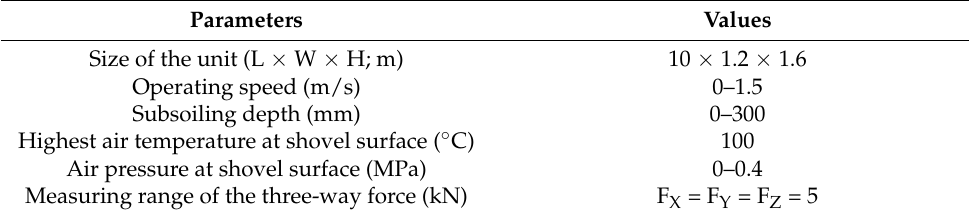
Figure 5. Setting of the soil-bin test. Table 3. Main parameters for the soil-bin test.